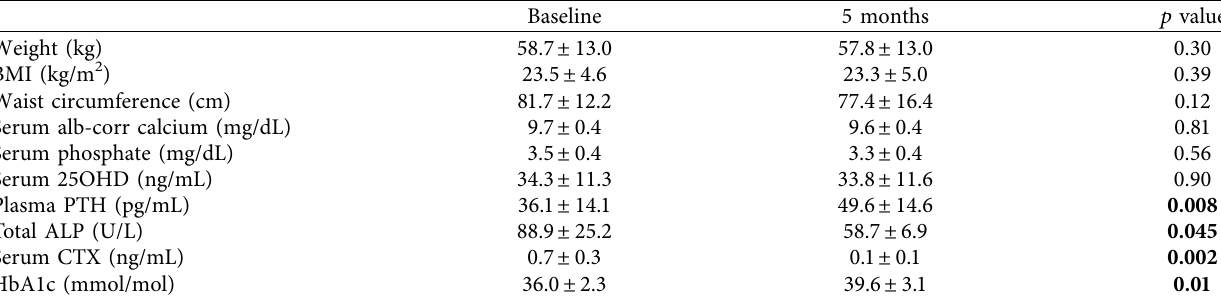
Table 1: Clinical and biochemical features of the postmenopausal breast cancer patients at baseline and 5 months after 60 mg Dmab